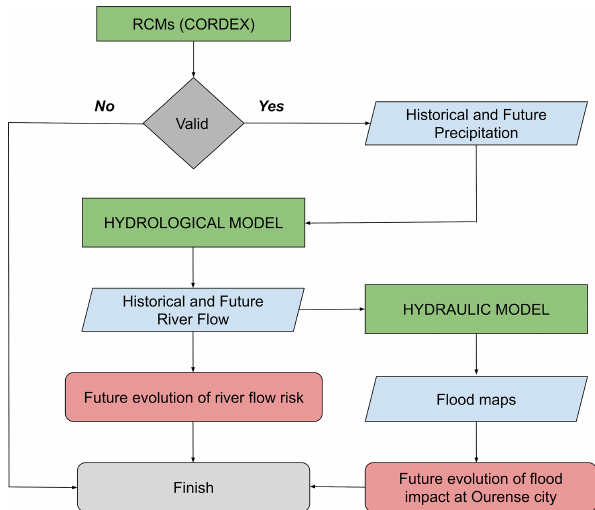
Figure 4. Flow chart of the developed